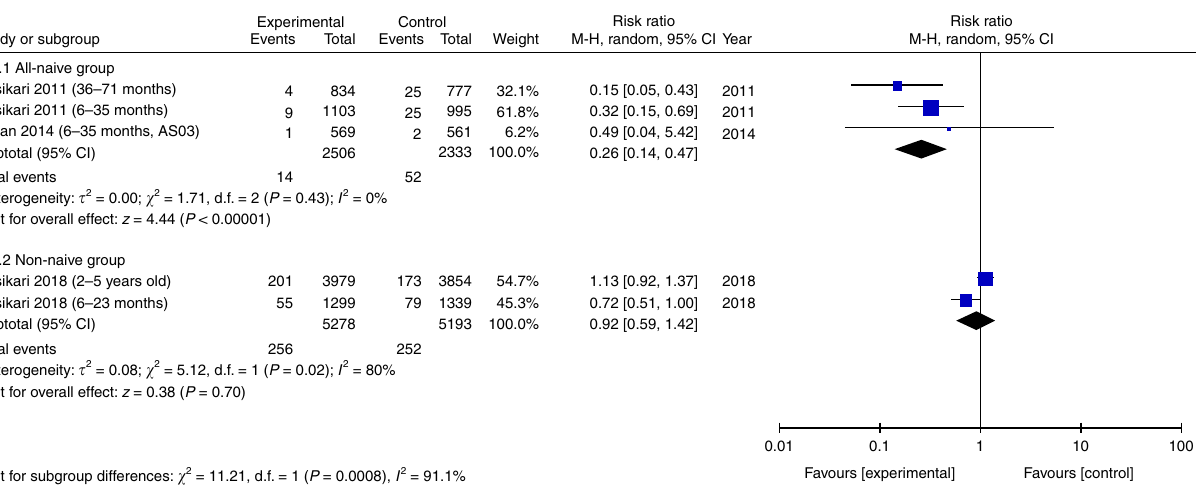
Fig. 2 Forest plot showing the risk ratios of RT-PCR-con fi rmed in fl uenza among children who received adjuvanted versus non-adjuvanted trivalent vaccines or quadrivalent vaccines.